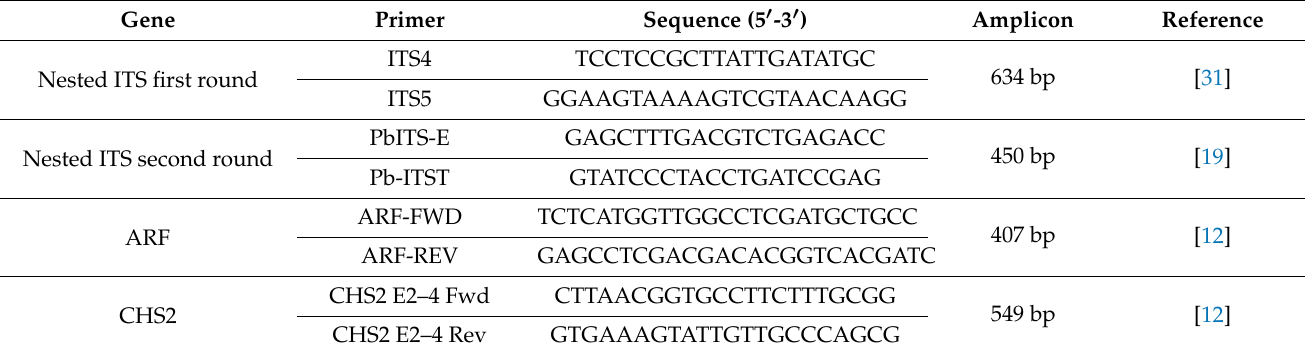
Table 1. Primers used in PCR amplification for our target loci